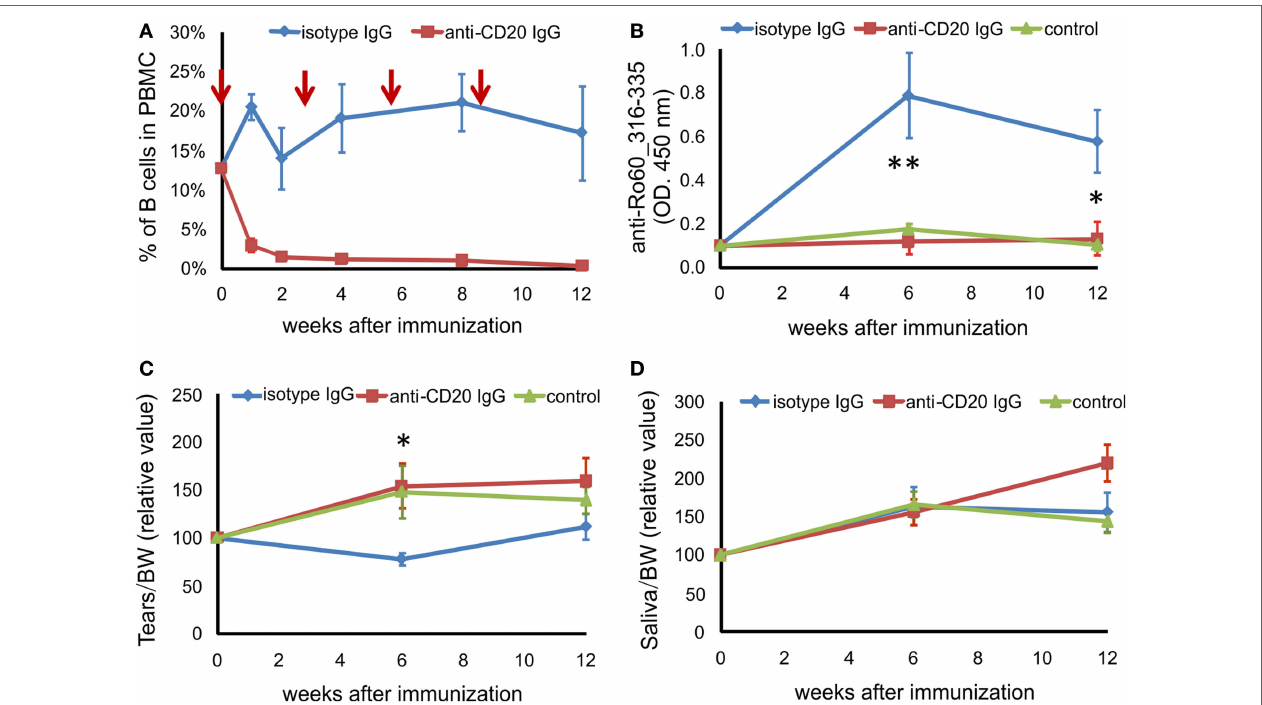
FigUre 3 | B cell depletion prevents mice from Ro60_315-336-induced primary Sjögren’s syndrome-like disease. Before and after immunization with Ro60_316- 335 peptide, C3H/HeN mice were injected i.p. with anti-CD20 IgG (red line) or isotype IgG (blue line). The control group (green line) represents mice immunized with PBS and adjuvants alone. (a) Efficiency of depletion of murine B cells in C3H/HeN mice. The time points of B cell-depleting anti-CD20 antibody injection are indicated by red arrows, the percentage of B cells in the peripheral blood mononuclear cells were determined at 0, 1, 2, 4, 8, and 12 weeks after immunization using CD19 as marker for B cells. (B) Autoantibodies against the mRo60_316-335 peptides in sera of isotype IgG treated ( n = 7) or anti-CD20 IgG treated ( n = 8) mRo60_316-335-immunized C3H/HeN mice, or PBS-treated control mice ( n = 6). Tears (c) and saliva (D) production in isotype IgG treated ( n = 7) or anti-CD20 IgG treated ( n = 8) mRo60_316-335-immunized C3H/HeN mice, or control mice ( n = 6). Data are presented as mean ± SEM. Statistically significant differences between isotype IgG ( n = 7) or anti-CD20 IgG treated ( n = 8) mice were calculated by the unpaired Student’s t -test with Welch’s correction (* p < 0.05, ** p < 0.01, unpaired Student’s t -test).